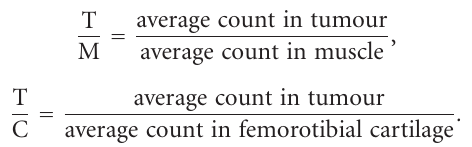
and intrinsic planar resolution of the system are given as